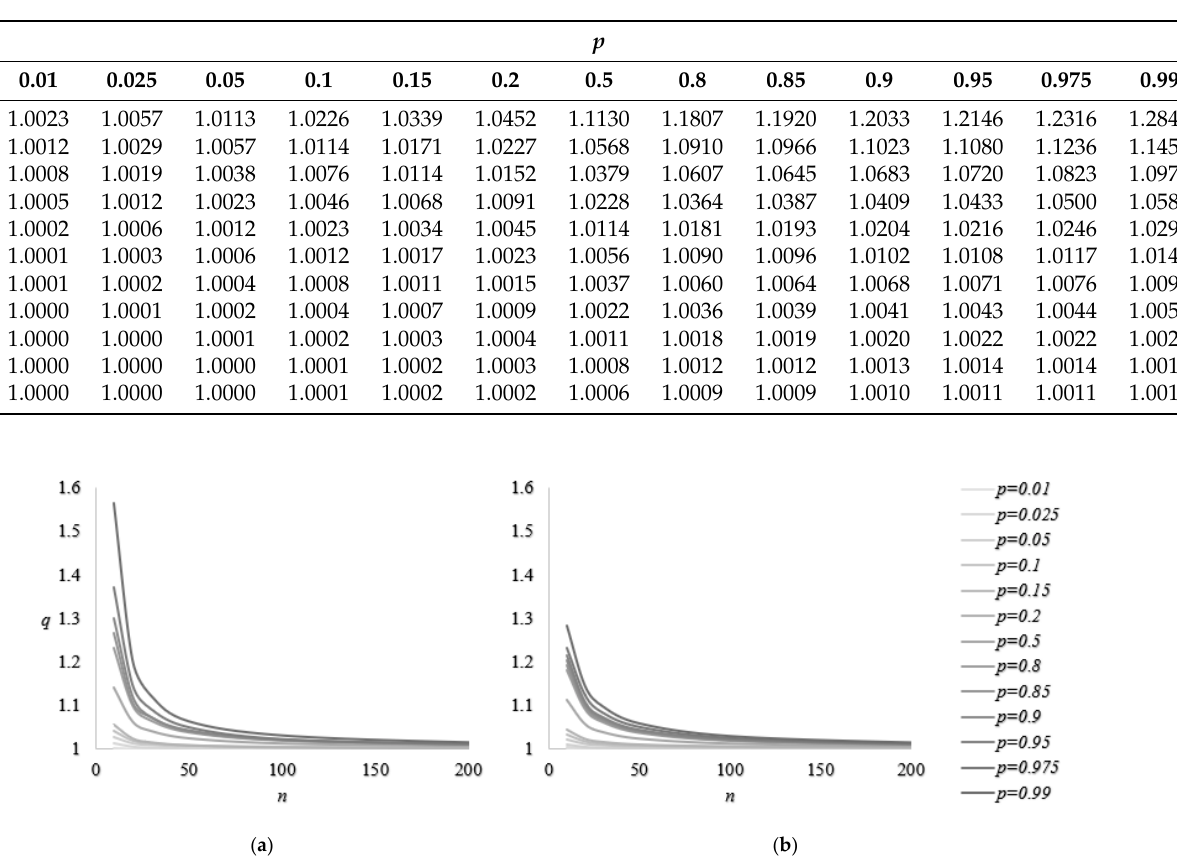
( q ) = P (cid:0) V n ≤ q (cid:1) = p —Estimated parameters. Table 4. F V n